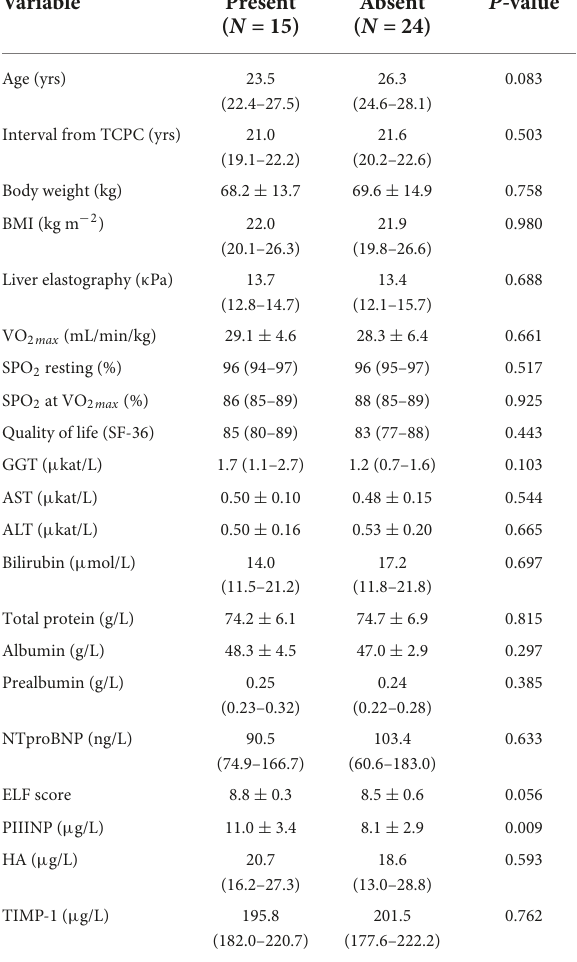
TABLE 6 Liver nodules, clinical data, and laboratory tests at the study.